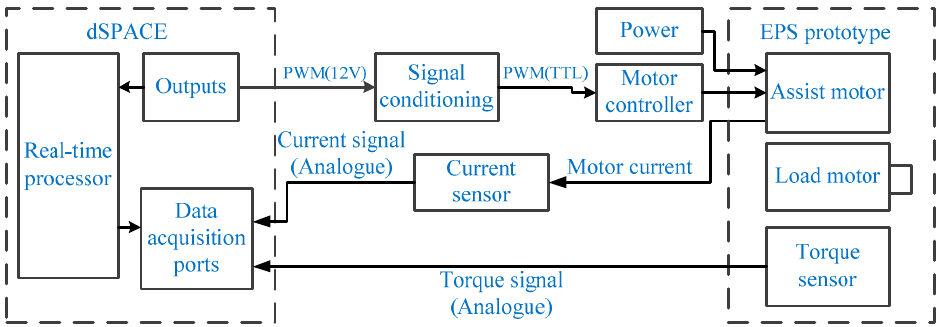
Figure 27. Block diagram of the verification experiment platform for the EPS control algorithm.